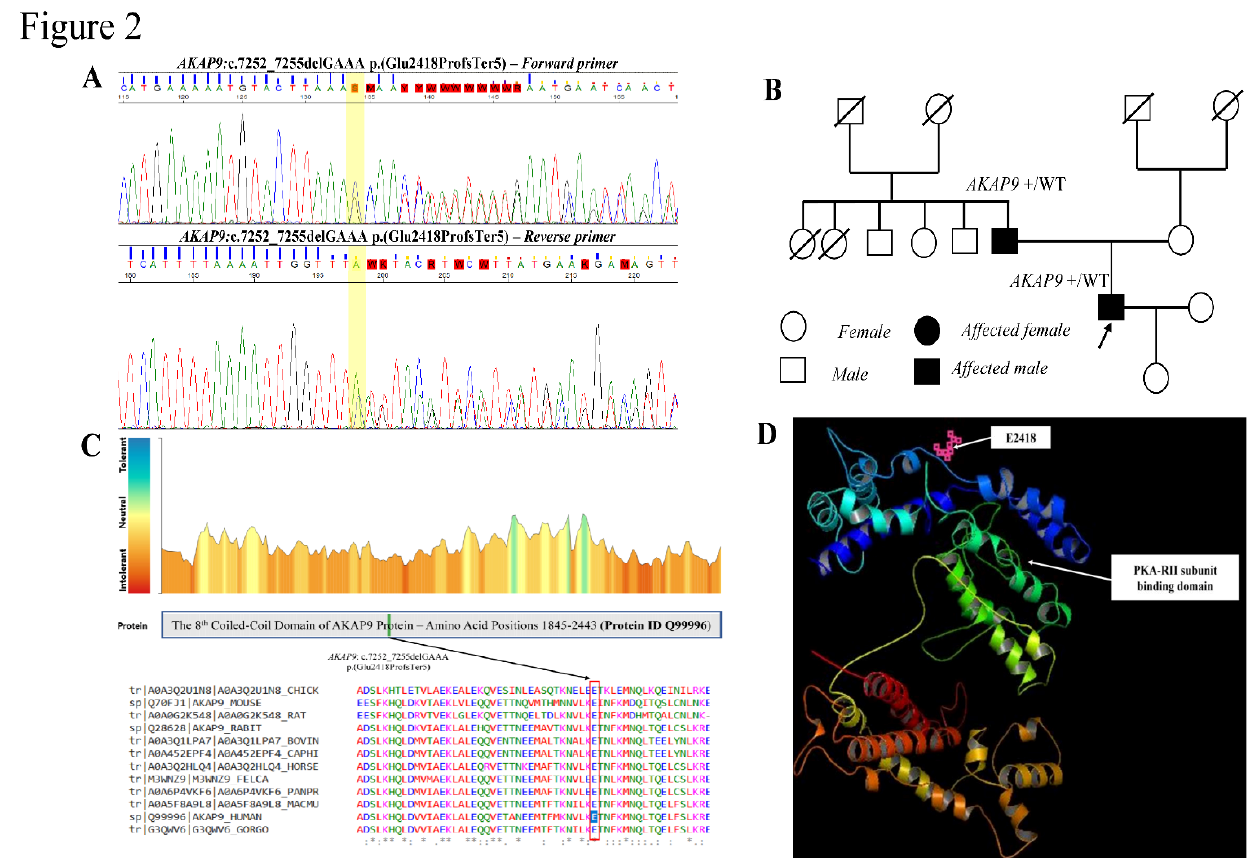
Figure 2. ( A ). Sanger sequencing showing a frameshift AKAP9 variant c.7252_7255delGAAA p.(Glu2418Profs*5) in the propositus. ( B ). Familial segregation study showing the pathogenic AKAP9 frameshift variant was inherited from an apparently normal father. ( C ). MetaDome showing a graphic representation of the tolerance scores of the affected Glu 2418 highly conserved among orthologs. ( D ). PyMOL showing the Yotiao 3D protein structure, the frameshift variant AKAP9 : c.7252_7255delGAAA p.(Glu2418Profs*5) leading to the production of truncated Yotiao protein lacking the PKA-RII subunit binding domain, resulting in reduced PKA-dependent phosphorylation of the Ser 27 located in the N terminus of I Ks α -subunit KCNQ1, which gives rise to the prolonged QTc interval.